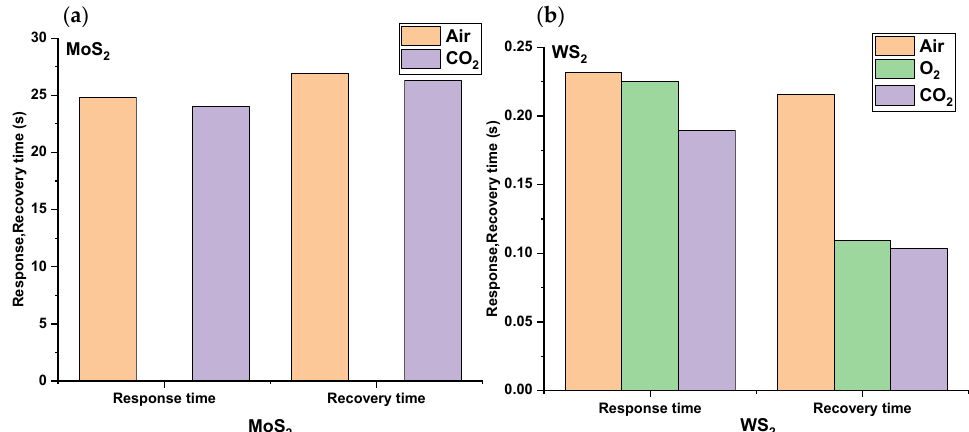
Figure 14. Shows the response and therecovery times for ( a ) MoS 2 and ( b ) WS 2 thin films under gas